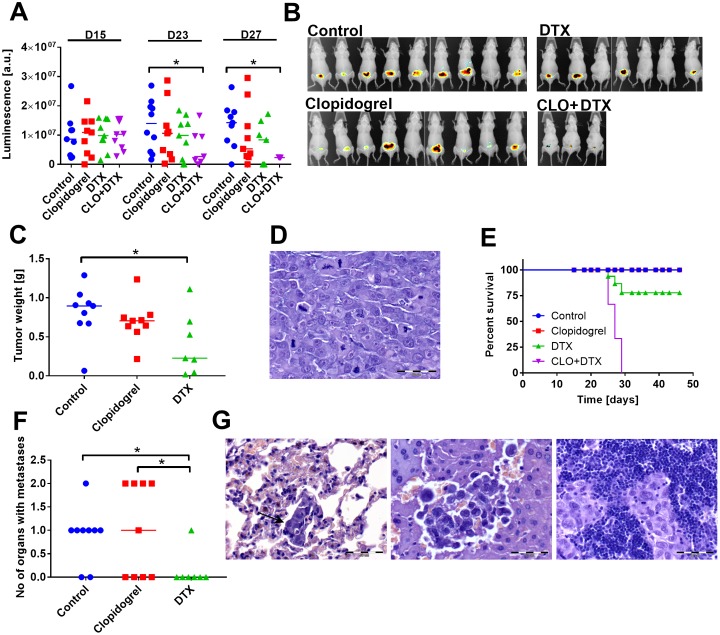
Clopidogrel increases the toxicity of docetaxel (DTX) in mice bearing human PC-3M-luc2 prostate tumors.(A) Luminescence of prostatic tumors on day 15 (day of treatment initiation), 23, and 27. (B) Photographs of mice on day 27 of experiment. (C) Tumor weight of tumors harvested on day 46. (D) Primary tumor tissue stained with hematoxylin and eosin (H&E) showing visible mitotic spindles. (E) Survival curves. (F) Number of organs with diagnosed metastases. (G) H&E-stained lung (left), liver (middle), and lymph node (right) tissue with micrometastases. All graphs show values for individual animals with median line with the exception of (E) shows percent of survival in indicated days. All mice were euthanized on day 46; the number of animals euthanized before: 12. N = 9 mice per group. Statistical analysis: Kruskal–Wallis test for multiple comparisons, *p<0.05. Survival analysis: Mantel–Cox test showed significant differences between survival curves (p<0.0001).